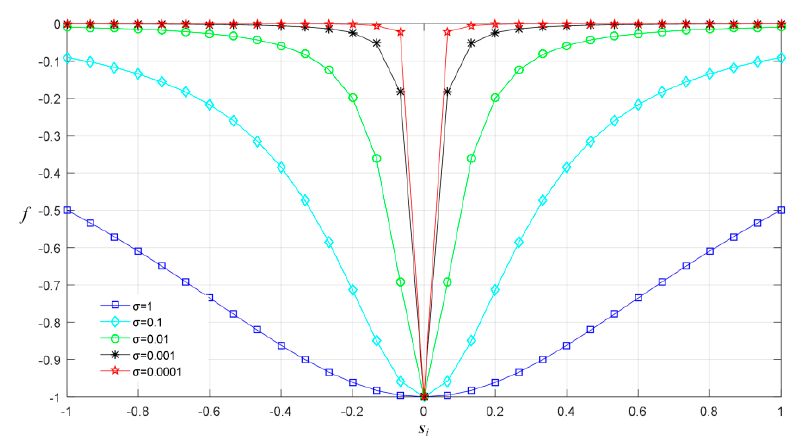
(cid:16) (cid:17) + σ s 2 . i